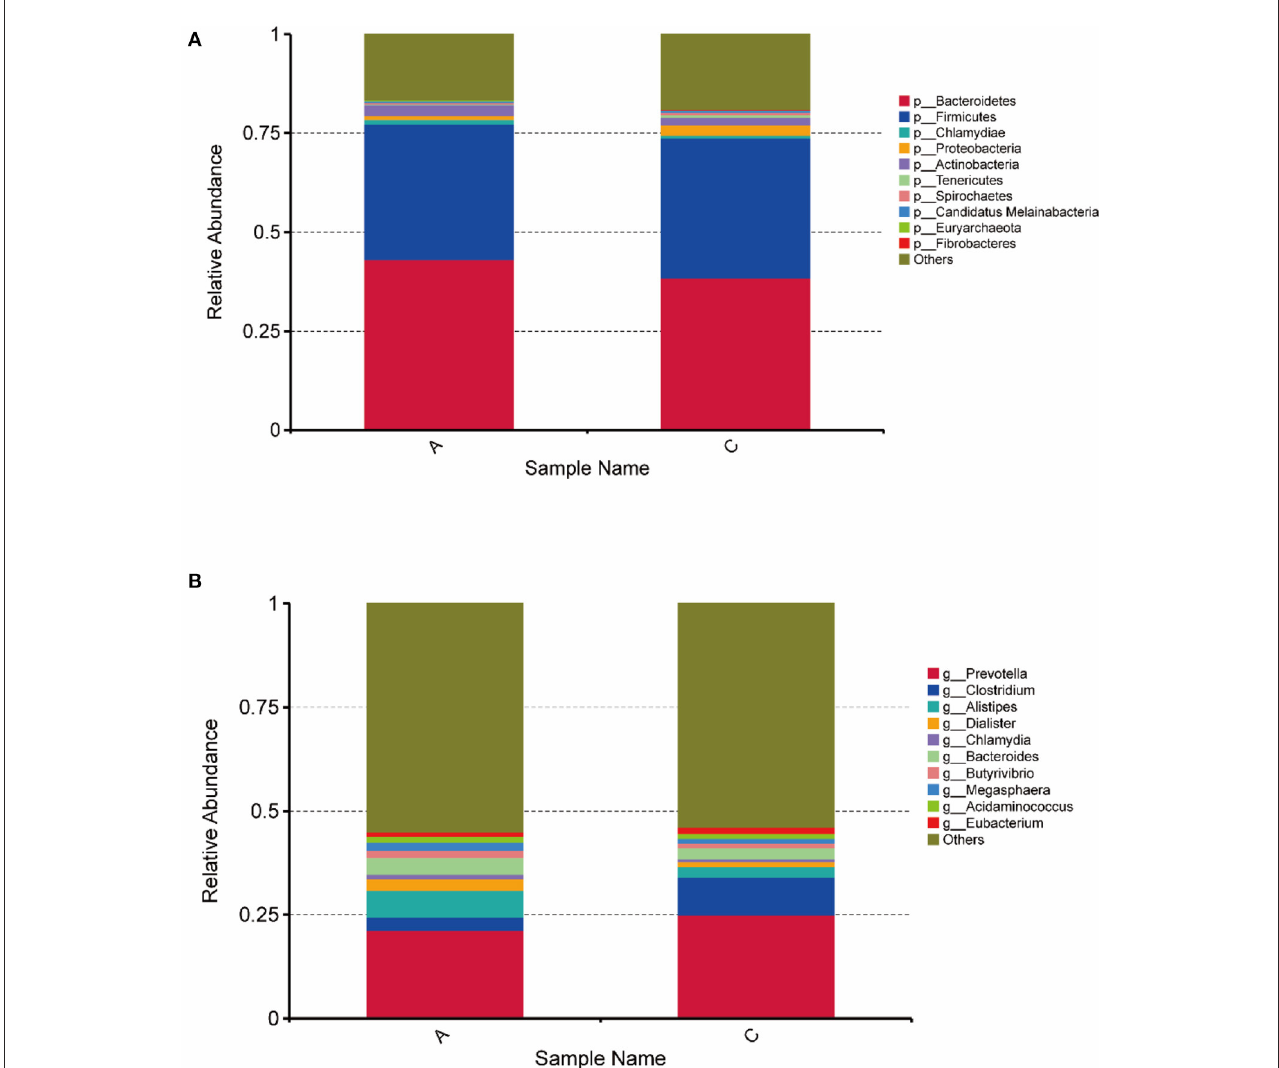
FIGURE2 Histogram of horizontal relative abundance of phylum (A) and genus (B) . The horizontal axis represents the sample name; the vertical axis represents the relative proportion of species annotated to a particular type; the legend on the right shows the species category corresponding to each color